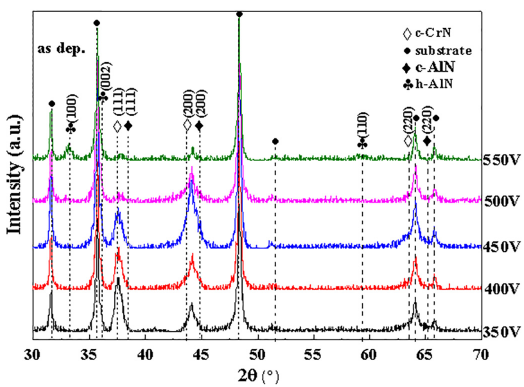
Figure 3. X ‐ ray diffraction (XRD) patterns of AlCrN coatings deposited at various charge voltages.